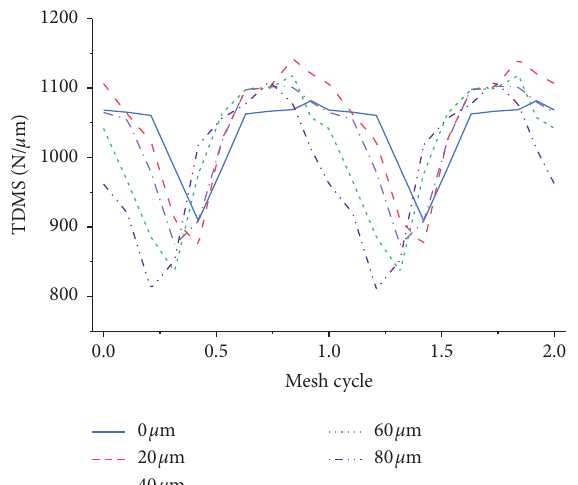
Figure 17: STE fluctuations of helical gear pairs under different mesh misalignment